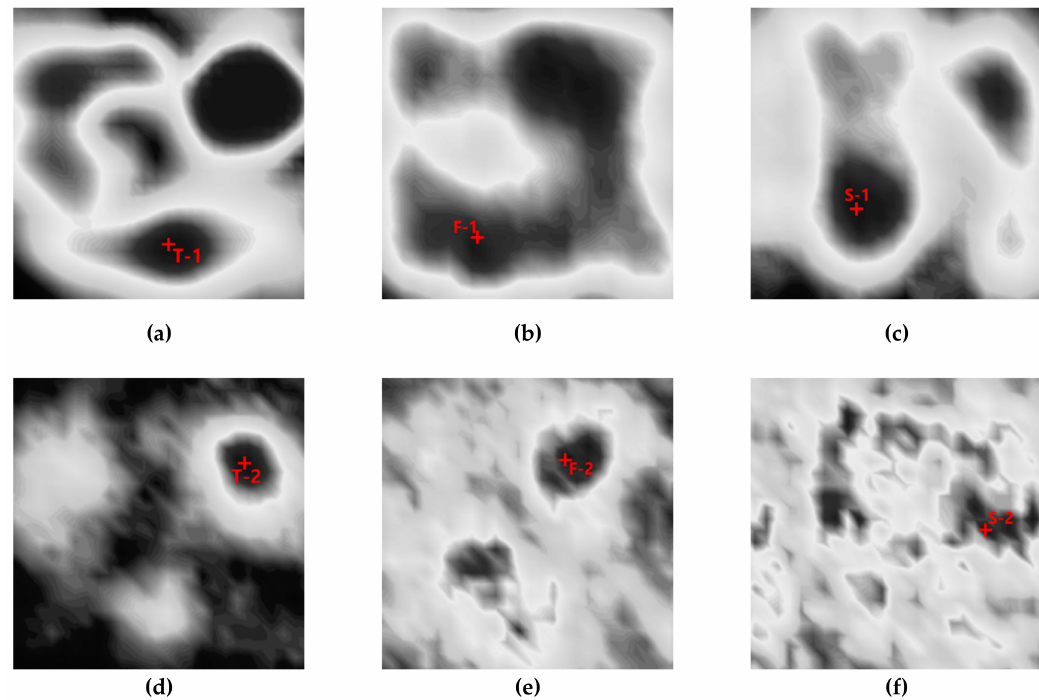
Figure 7. C-scan images with points of the highest amplitude as determined by the first back-surface echo obtained from scanning toward the ( a ) top, ( b ) front, and ( c ) side planes and by the second back-surface echo obtained from scanning toward the ( d ) top, ( e ) front, and ( f ) side planes.